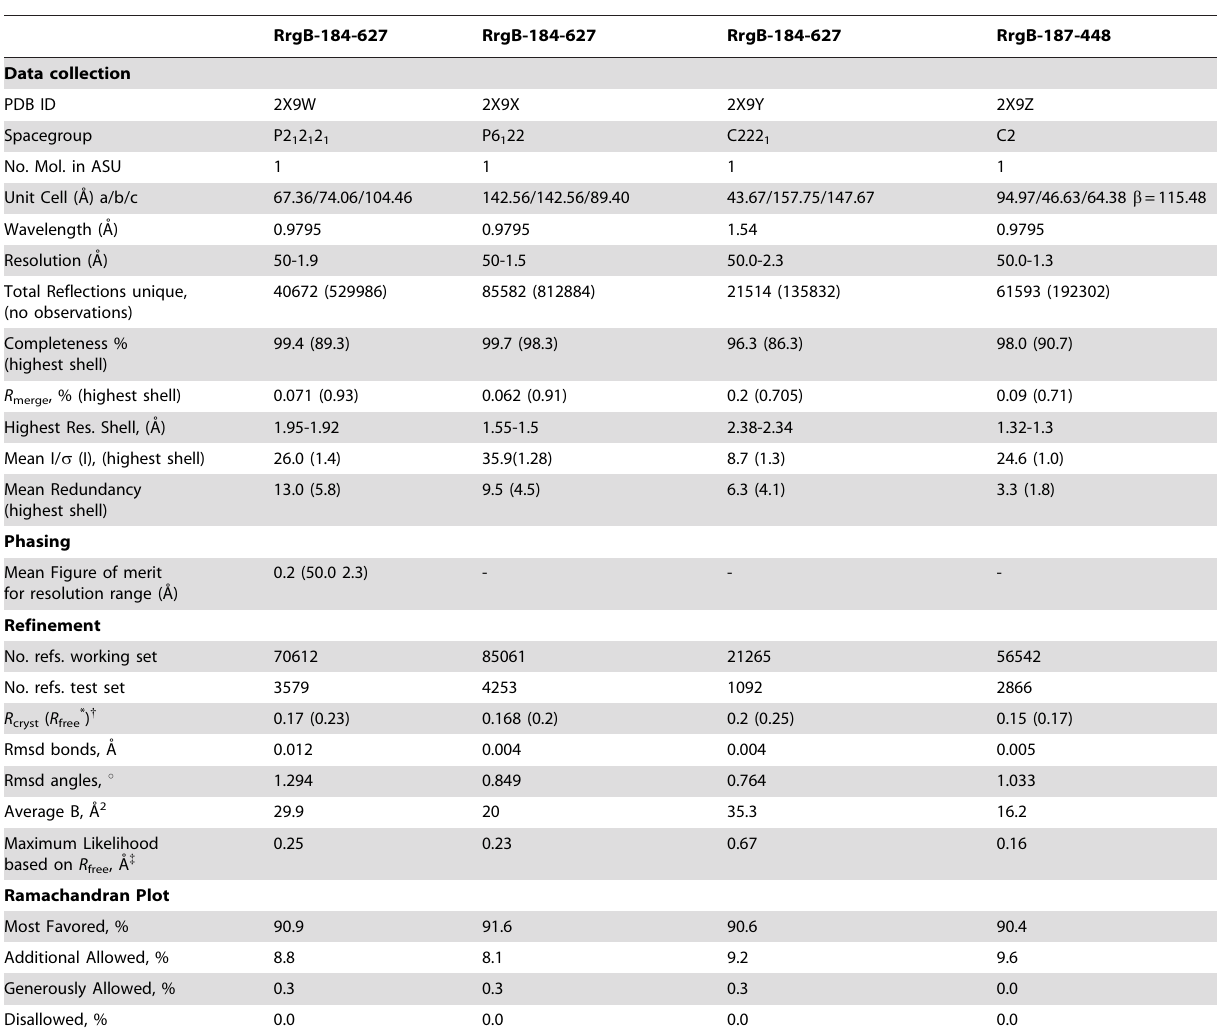
Table 1. Crystal forms of RrgBD2–D4 and of RrgBD2–D3